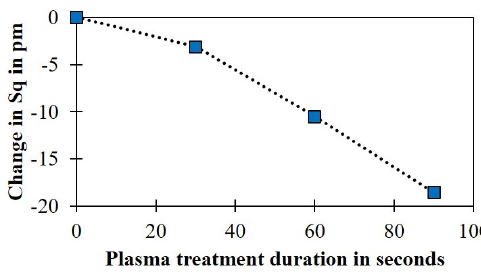
Fig. 4. Change in quadratic mean area roughness Sq of sapphire surfaces vs. plasma treatment duration.